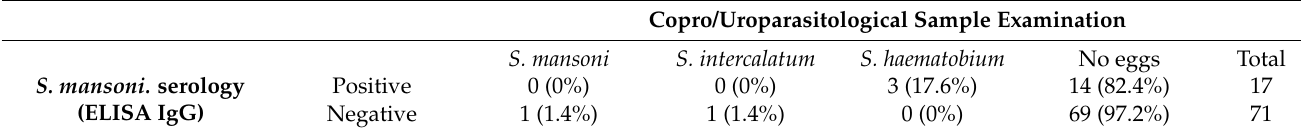
Table 3. Correlation between serology and copro-uroparasitological